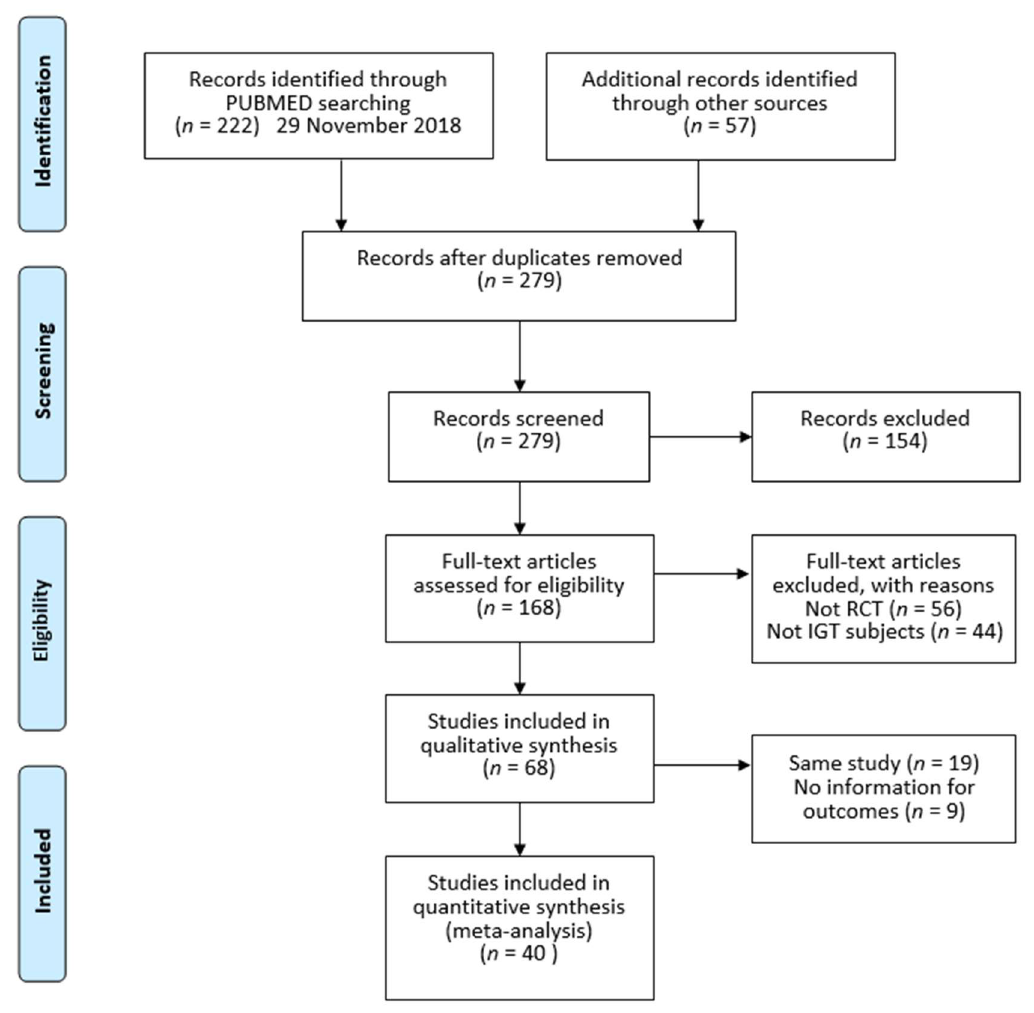
Figure 1. Flow diagram. RCT: randomized controlled trial, IGT: impaired glucose tolerance